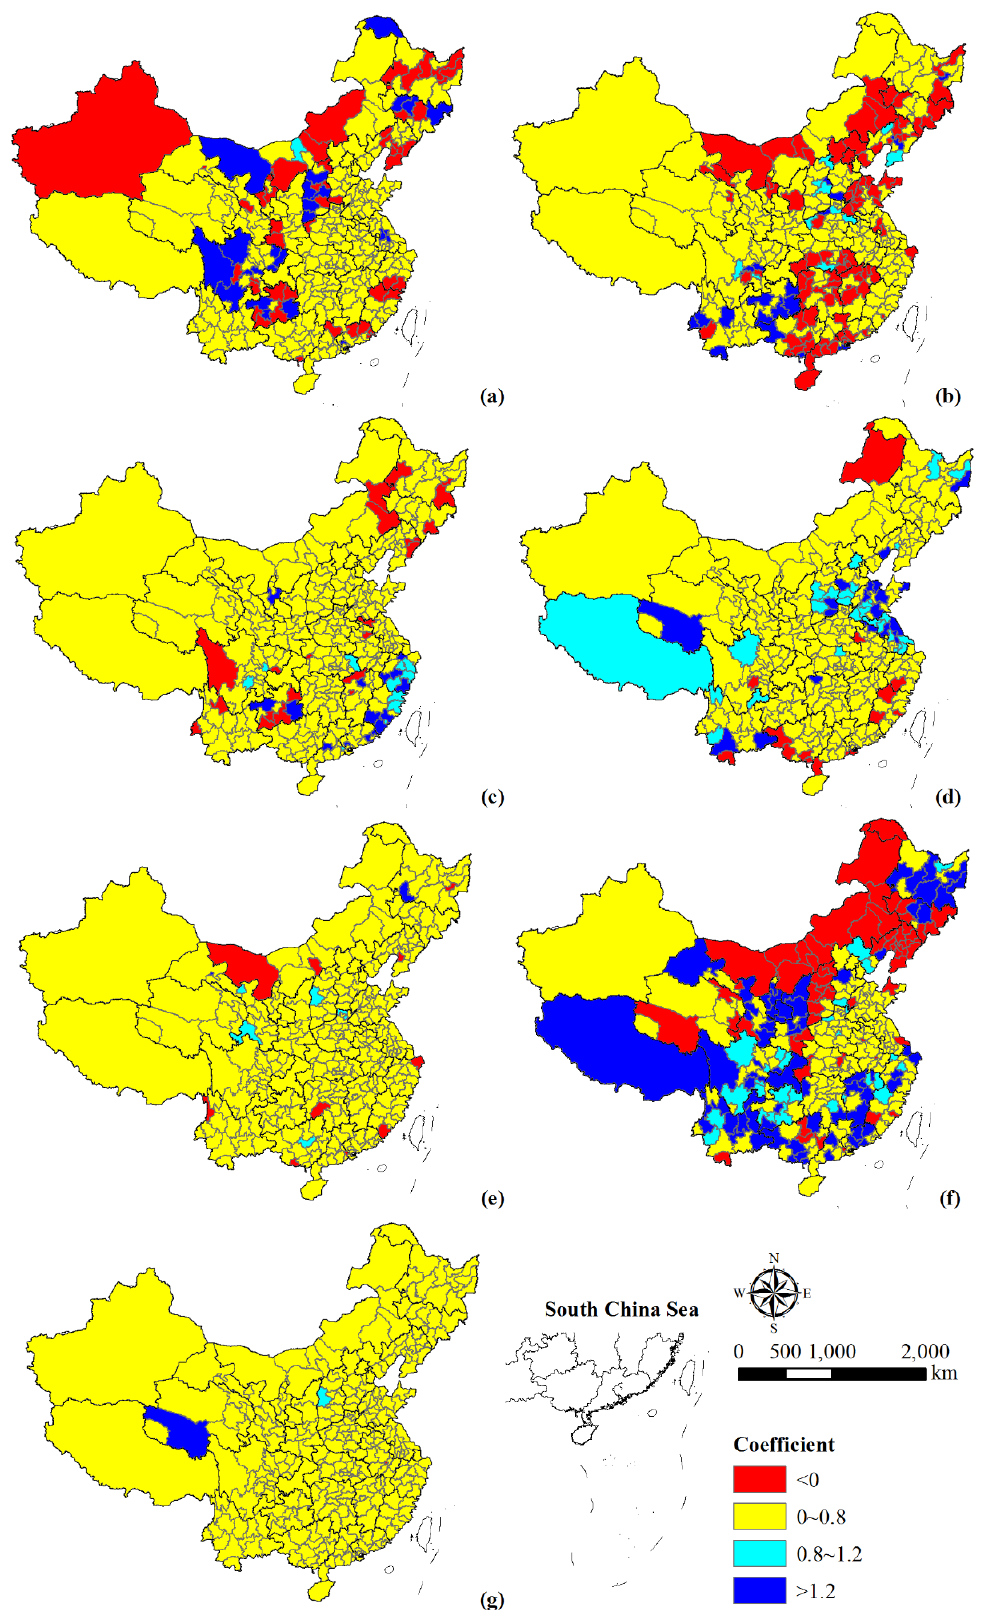
Figure 6. Spatial variation of the elasticity coefficient between construction land and GDP during 1990–1995 ( a ), 1995–2000 ( b ), 2000–2005 ( c ), 2005–2010 ( d ), 2010–2015 ( e ), 2015–2018 ( f ), and 1990–2018 ( g